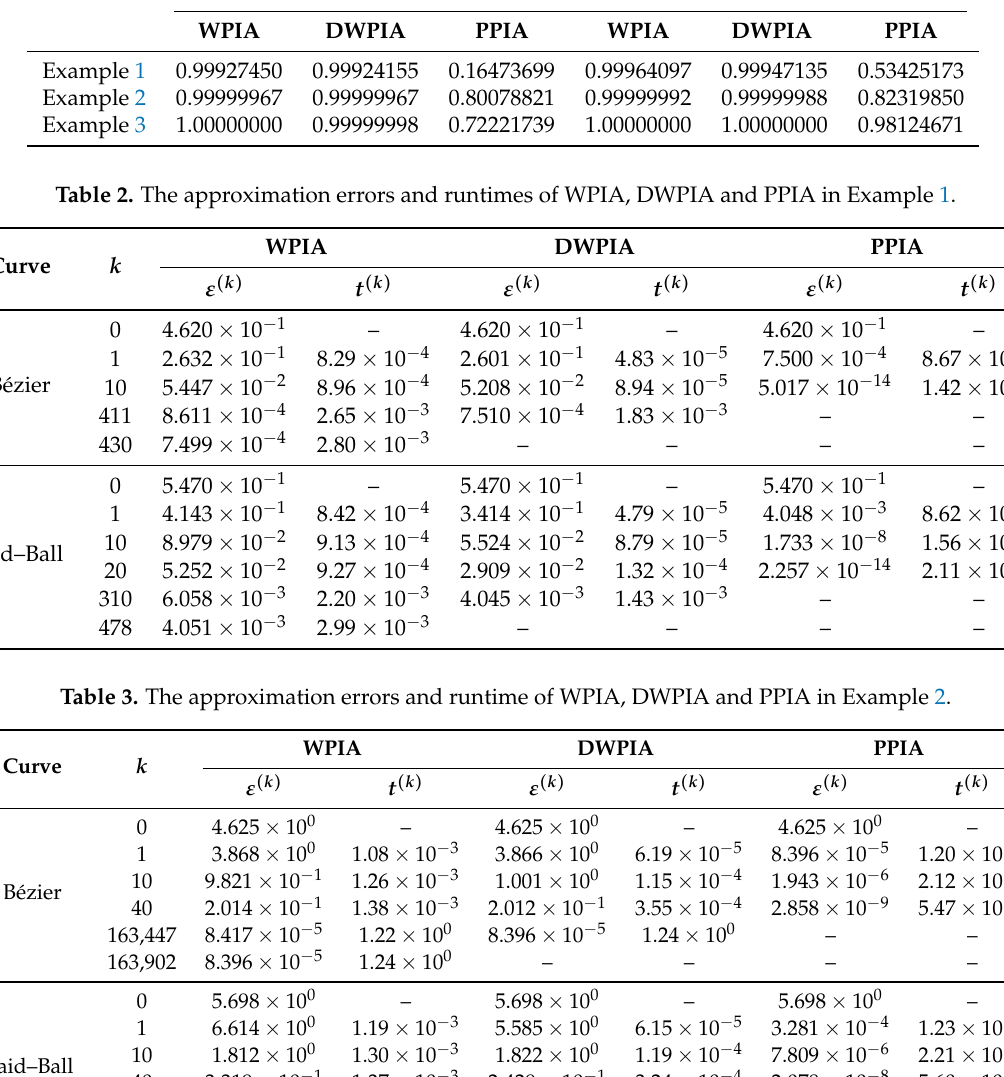
Table 1. The spectral radii of iteration matrices of WPIA, DWPIA and PPIA in Examples 1–3.